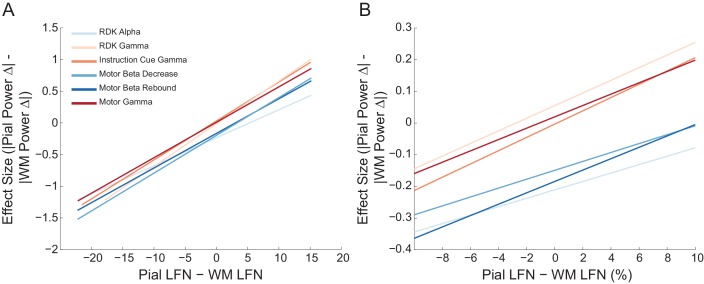
The relationship between pial and white matter lead field strength and laminar preference is the same across frequency bands.Each panel shows the fitted linear relationship between the difference in lead field strength between the pial and white matter surfaces (pial lead field norm – white matter lead field norm), and the effect size (Cohen’s d) of the unsigned fractional change in power from baseline on the pial surface, minus the unsigned fractional change in power on the white matter surface. The panels show this relationship for pairs of corresponding pial/white matter vertices over the whole range of lead field norm differences (A) and within ±10% of the average pial/white matter lead field norm difference (B) over all participants. There is no significant effect of frequency band or region on the correlation between lead field norm difference and laminar preference.